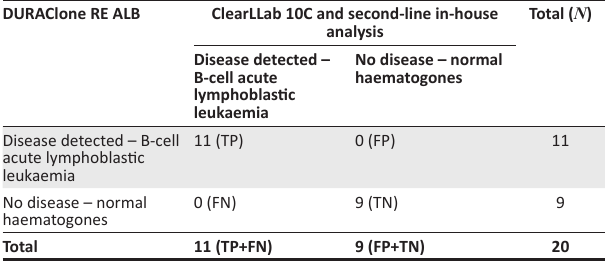
TABLE 3: Comparison of predicate reagents and DURAClone RE ALB reagent during the assessment of normal and abnormal precursor B-cells undertaken